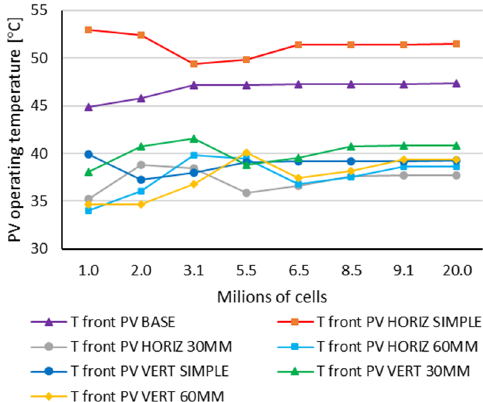
Figure 2. Mesh independence study for the numerical simulation.